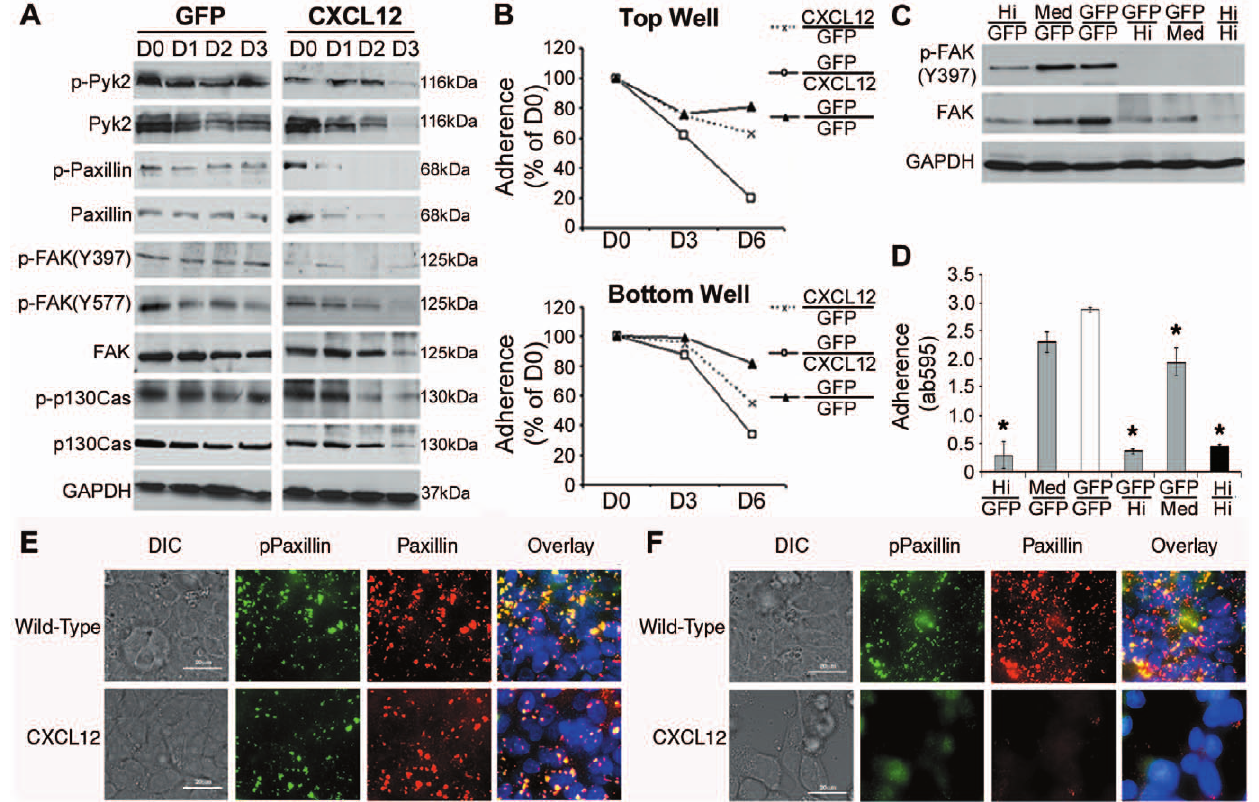
Figure 2. Constitutive CXCL12 stimulation induces a loss in adhesion through destabilization of focal adhesions. (A) HT29 cells expressing CXCL12 or GFP were grown to confluency as an adherent monolayer and then serum-starved three days (D0–D3). Total cell lysates were collected and immunoblot analysis conducted to examine both activation and presence of various focal adhesion proteins. GAPDH served as a loading control. CXCL12 expression resulted in a loss of focal adhesion activation, indicated by diminished phosphorylation, and loss of total protein levels. (B) CXCL12 or GFP HT29 cells were separately grown to confluency on filters or plastic and then co-cultured in serum-free medium. Adherent cells were quantified by crystal violet staining after 3 or 6 days and compared to baseline adherence at day 0. Co-cultures are identified by fractions with the numerator representing cells in the top-well insert and denominator representing cells in the bottom-well. CXCL12-expressing cells induce a decrease in cellular adhesion in control cells. (C) Lysates from cells in the top-well after six days of co-culture were collected to examine FAK activation and stability. Constitutive CXCL12 stimulation diminished active and total FAK levels whereas control (GFP/GFP) cells were unaffected. Data from panels A-C are representative of three independent experiments. (D) Transwell co-cultures with HT29 cells expressing variable levels of CXCL12 resulted in a dose dependent decrease in adhesion. Values of top-well crystal violet staining shown are mean 6 SD from three independent experiments completed in triplicate. * indicates statistically significant difference in panel D from GFP/GFP co-cultured cells ( P # 0.05). (E,F) Immunofluorescence staining and overlay ( yellow ) of active phosphorylated paxillin ( green ) with total paxillin protein ( red ) demonstrated the localization of focal adhesions in HT29 cells at day 0 (E) and day 3 (F) of adherent cultures. Size bar equals 20 m